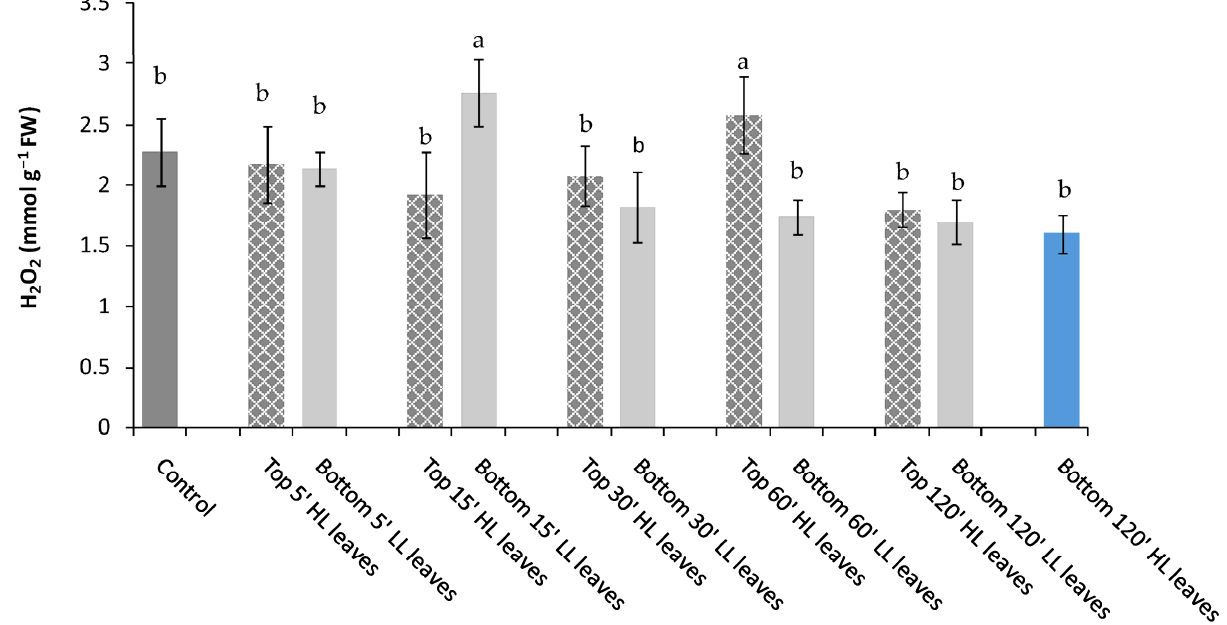
Figure 3. H 2 O 2 content in P. vulgaris L. Control, Top 5’, 15’, 30’, 60’, and 120’ HL leaves (inducing stressed after 5’, 15’, 30’, 60’ and 120’ of light stress), Bottom LL leaves (receiving unstressed) and Bottom 120’ HL leaves (receiving leaves after 120’ of light stress). Different letters indicate statisti- cally significant difference among treatments ( p ≤ 0.05) by One-Way ANOVA followed by Holm–Sidak post-hoc test.